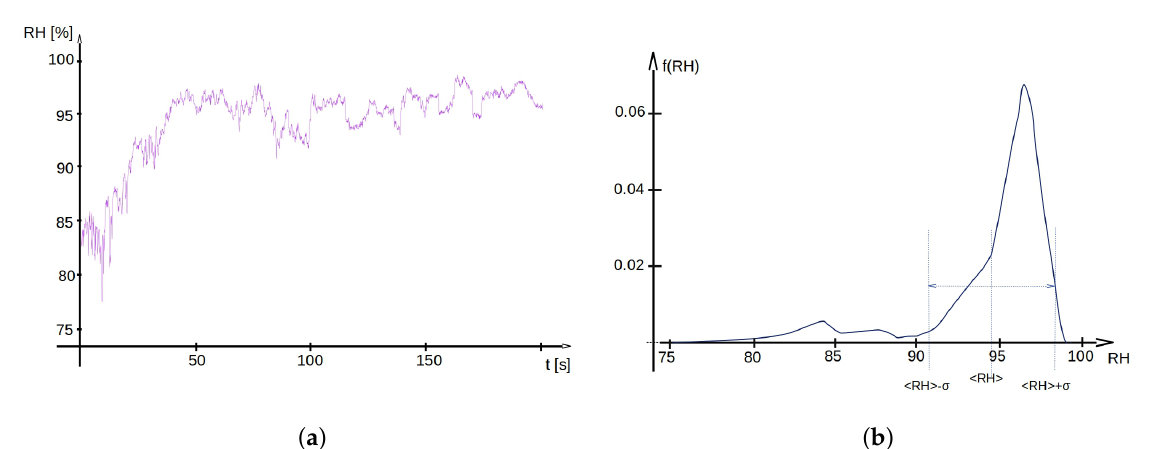
Figure 2. Airborne measurements of relative humidity (RH): ( a ) the time series of the signal; ( b ) the resulting PDF. Data obtained from the CIRPAS Twin Otter aircraft during the “Physics of Stratocumulus Top” project